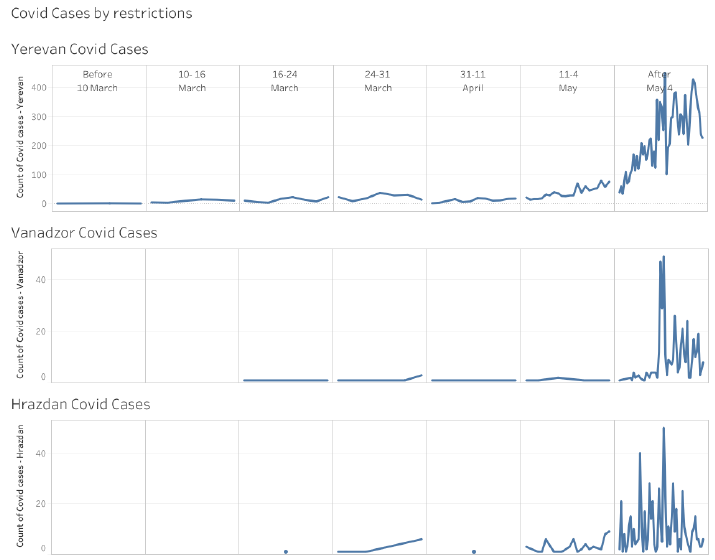
Figure 4. New COVID-19 cases in Yerevan, Vanadzor and Hrazdan during March – June 2020 during and after the lockdown. Table 2 shows Spearman’s rank correlation between the dust, SO 2 and NO 2 and new cases of COVID-19 after different lags (from 1 to 14 days) in Yerevan, Hrazdan and Vanadzor during the March – June 2020 period. There was a negative correlation between the concentration of dust and new cases of COVID-19 in all three cities. The strongest correlation in Yerevan was during the first five days of lag ( − 0.33 to −0 .30), while in Hrazdan the strongest was seen after 10 – 12 days ( −0 .33). In Vanadzor there was no statistically significant correlation. Table 2. Correlation between concentrations of dust, SO 2 and NO 2 with new cases of COVID-19 in Yerevan, Hrazdan and Vanadzor with 1 – 14 lag days. A grey color denotes a significant ( p -value <0.05) correlation.